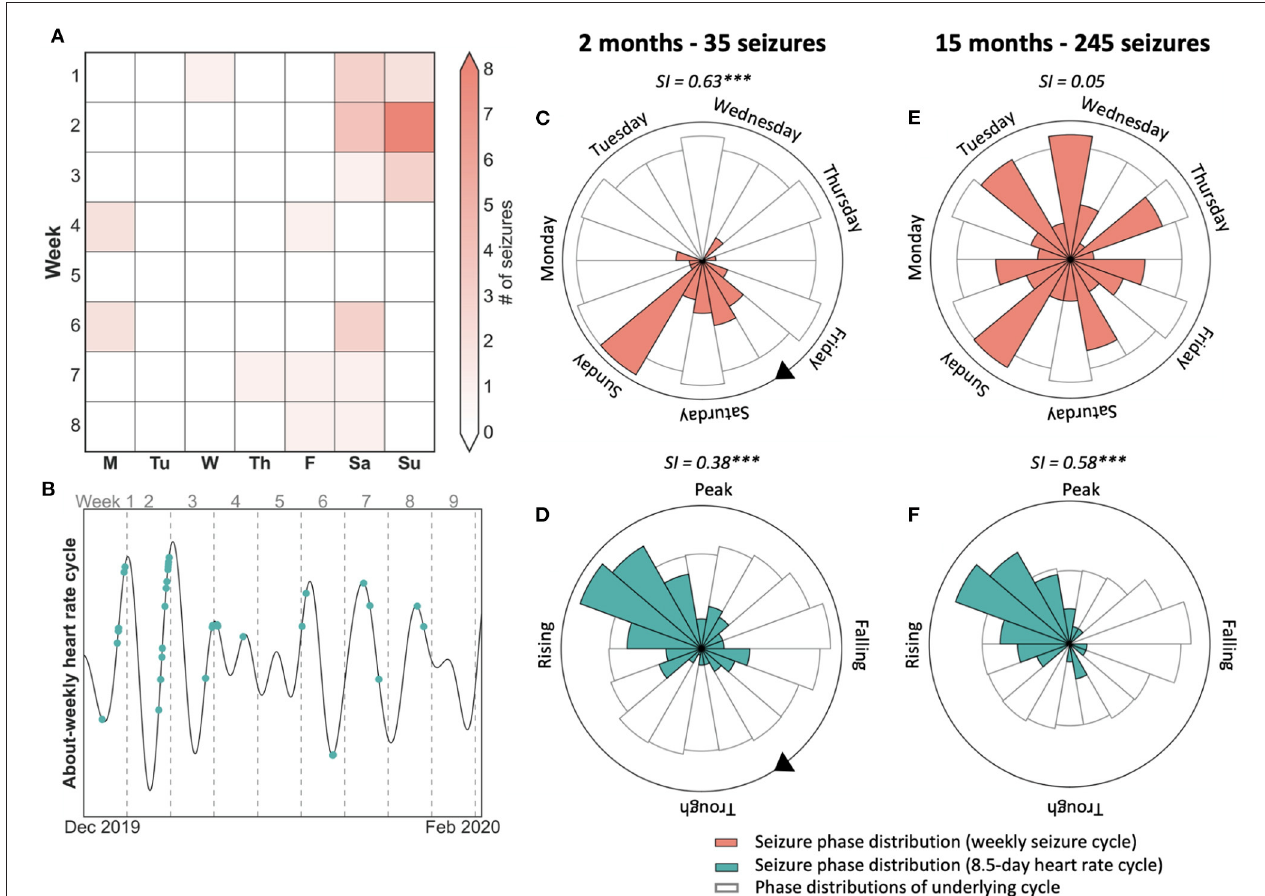
FIGURE 2 | Case study of 7-day weekly seizure cycle and 8.5-day heart rate cycle showing that seizures were not modulated by weekly behaviour. (A) 8-week seizure diary showing days that seizures occurred, suggesting a weekly seizure cycle. (B) 8.5-day heart rate cycle of the same period as (a), with seizures shown in green. Seizures tend to occur on the rising phase of the cycle, with a few exceptions. (C,D) Polar plots demonstrating the location of seizures with respect to the 7-day seizure (red) and 8.5-day heart rate cycle (green) after two months and 35 seizures. Seizures were more strongly locked to the 7-day week. (E,F) Polar plots demonstrating seizure timing on the seizure and heart rate cycle after 15 months and 245 seizures. Seizures were no longer locked to the weekly cycle but remained strongly locked to the 8.5-day heart rate cycle. SI, Synchronisation index value with significance according to Omnibus test (*** p < =